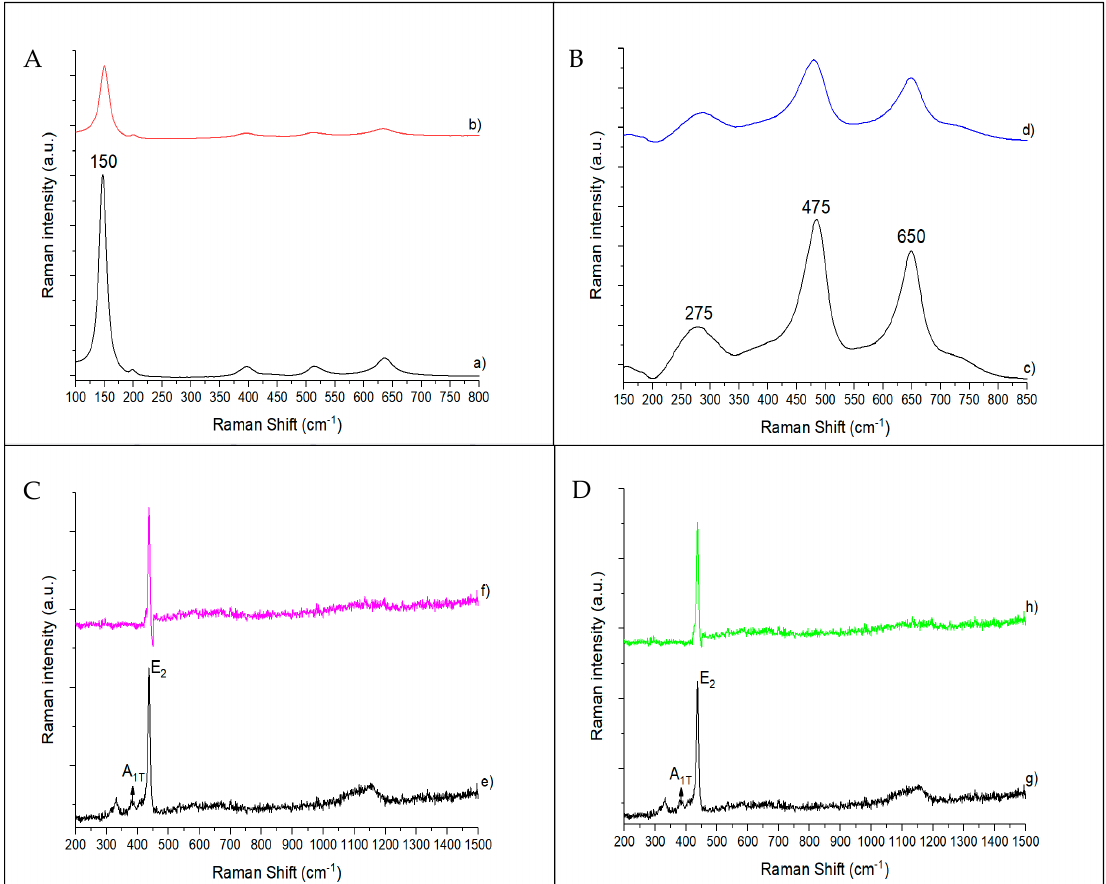
Figure 4. Raman spectra of TiO 2 -P25 ( A ,a), 10%Ag@TiO 2 -P25 ( A ,b), TiO 2 NWs ( B ,c), 10%Ag@TiO 2 NWs ( B ,d), ZnO commercial ( C ,e), 10%Ag@ZnO commercial ( C ,f), ZnO NWs ( D ,g), and 10%Ag@ZnO NWs ( D ,h) catalysts.